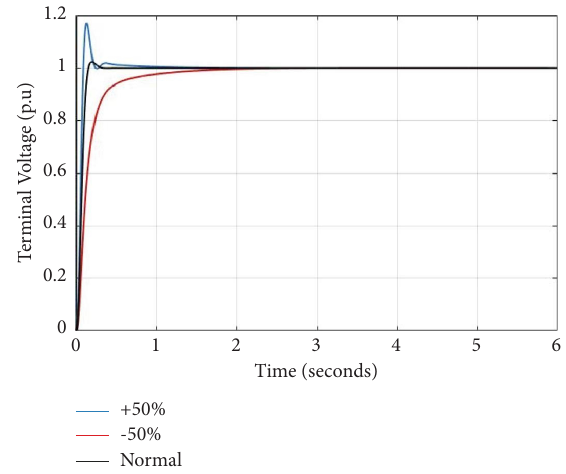
Figure 17: Response of terminal voltage using MESOBC for normal and ± 50% uncertainties in K